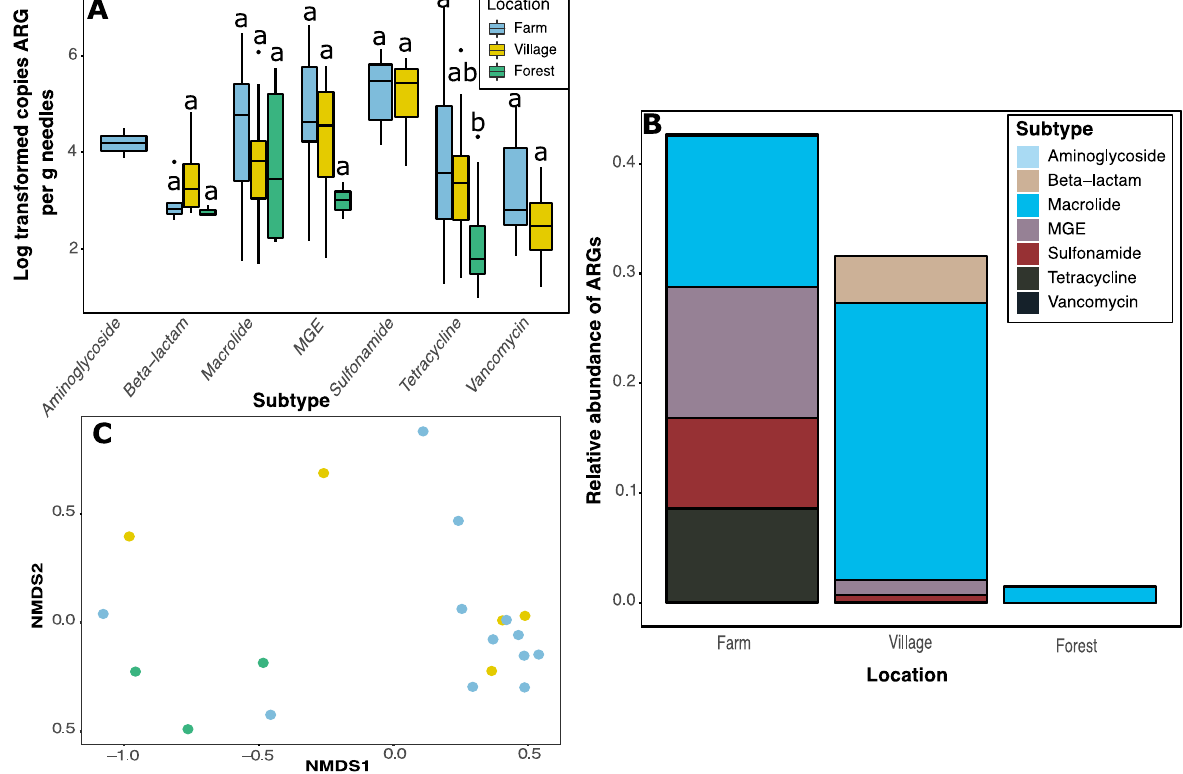
Figure 2. Analysis of ARGs detected in conifer needle samples. ( A ) Boxplot of copy numbers of ARG subtype. Boxes represent the data within the first and third quartiles; the horizontal line marks medians; whiskers represent 1.5× the interquartile range; black dots denote outliers. ( B ) Relative abundance of ARGs in each sampling area. ( C ) Nonmetric multidimensional scaling ordination of needle phyllosphere samples based on copy number estimates of all ARGs. Each dot indicates a single sample. Colours correspond to the legend in panel ( A ) .